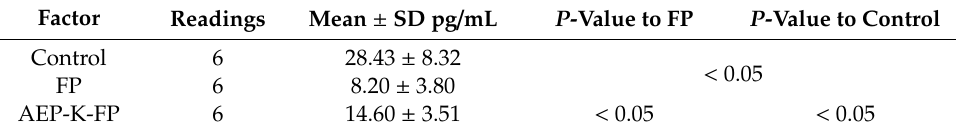
Table 2. Quantification of γ -secretase enzyme after exposure to free FP and AEP-K-FP. Factor